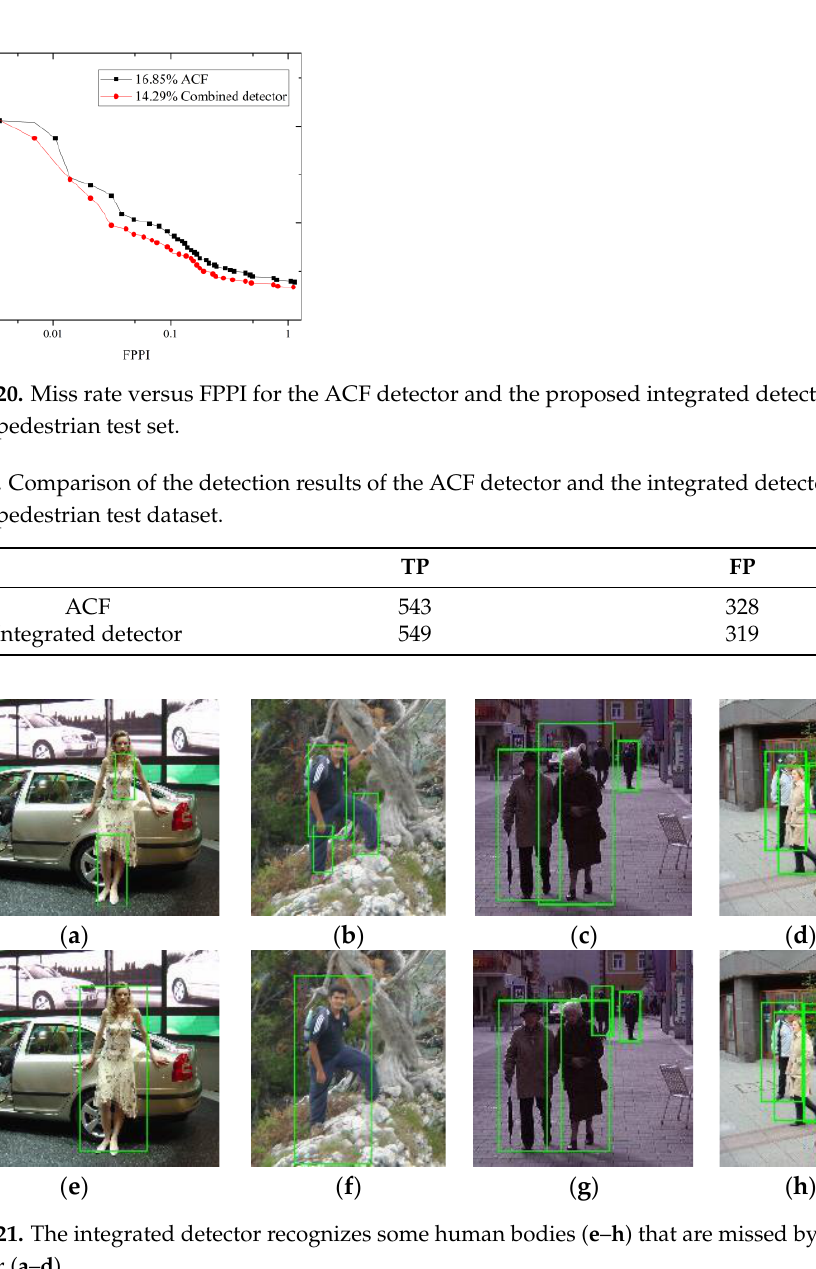
Figure 21. The integrated detector recognizes some human bodies ( e – h ) that are missed by the ACF detector ( a – d ).